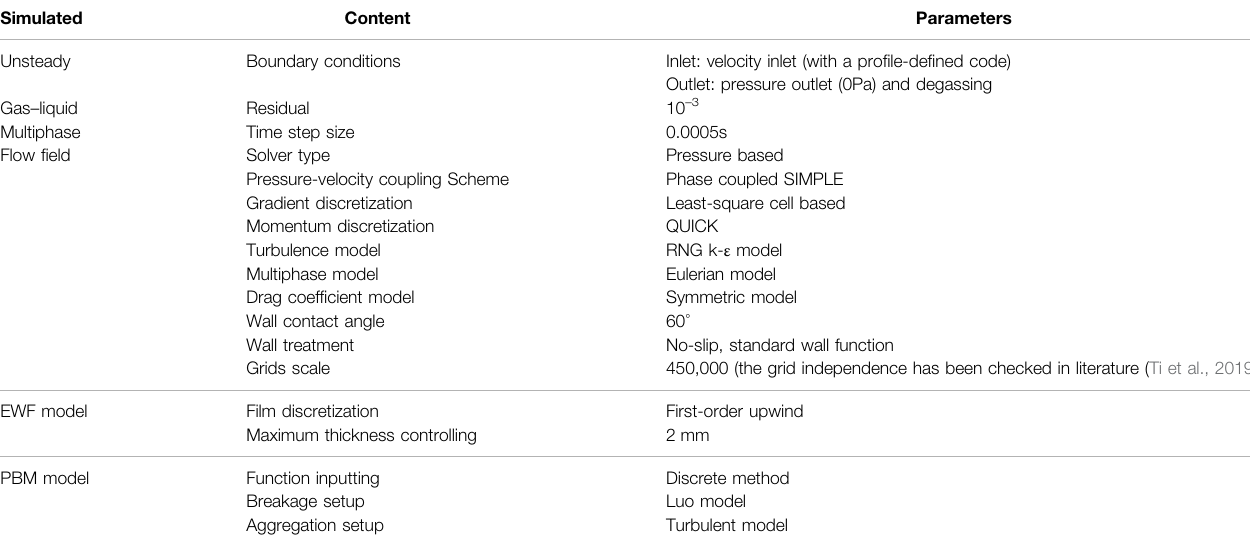
TABLE 1 | Settings of the whole simulated program. Simulated